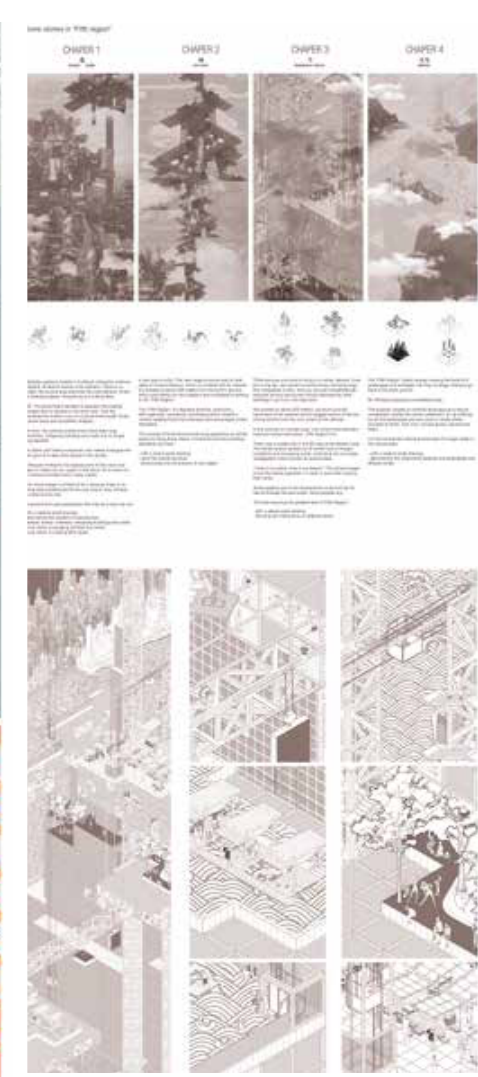
Figure 6 (top): Work in progress. Figure 7: Chapter 6, Artificial Nature. Narrates the changing adaptation of the Fifth Region, highlighting how the people living inside the Fifth Region for some years already and how they are starting to yearn for a natural environment. This results in the formation of new modes of artificial nature and a new consciousness of how to construct nature. Source: Lucas Kwok. Figure 8 (next page): Chapter 7, Vertical Climate. As the Fifth Region grows ever upwards an important part of the evolution deals with how a new vertical climate can be established to deal with living in the clouds, which includes for instance water harvesting from cloud wa- ter vapor. Source: Lucas